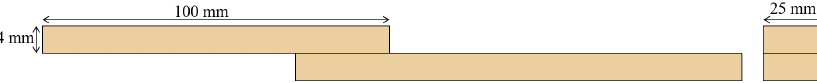
Figure 6. Dimensions of the SLJs tested.